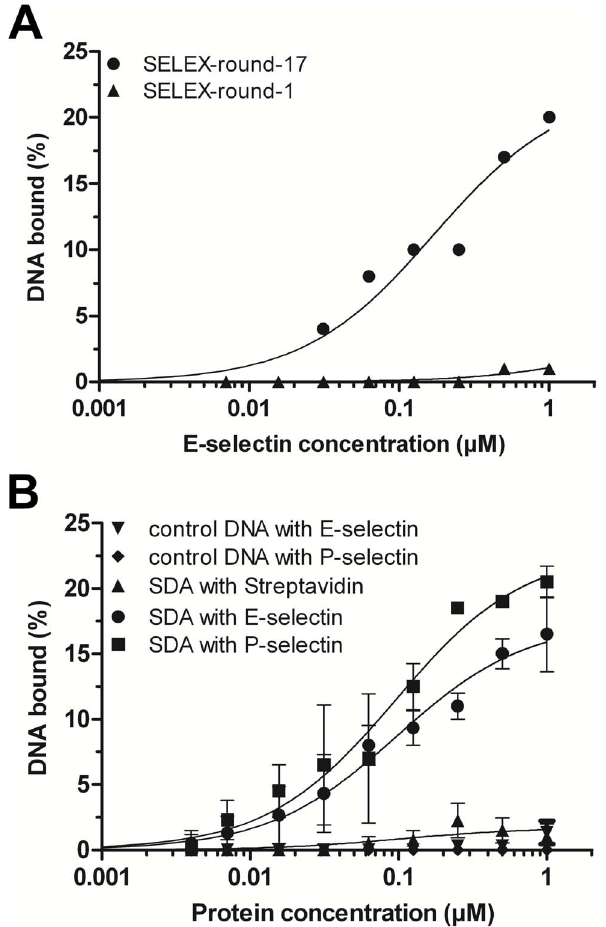
Figure 3. Affinities of selected DNA aptamers to rh E- and rh P- selectin determined via filter retention assays (FRA). DNA was radiolabeled, incubated with increasing amounts of proteins and filtrated through a nitrocellulose membrane. Fractions of bound DNAs were detected via autoradiography and quantified. (A) Recombinant human E-selectin incubated with DNA pool after one ( m ) and 17 ( SELEX rounds. (B) Aptamer SDA incubated with rh E-selectin ( 87 nM), rh P-selectin ( & , K d < 84 nM), or streptavidin ( m ) as a control. A control DNA did neither bind to human E- ( . ) nor P-selectin ( ¤ ).